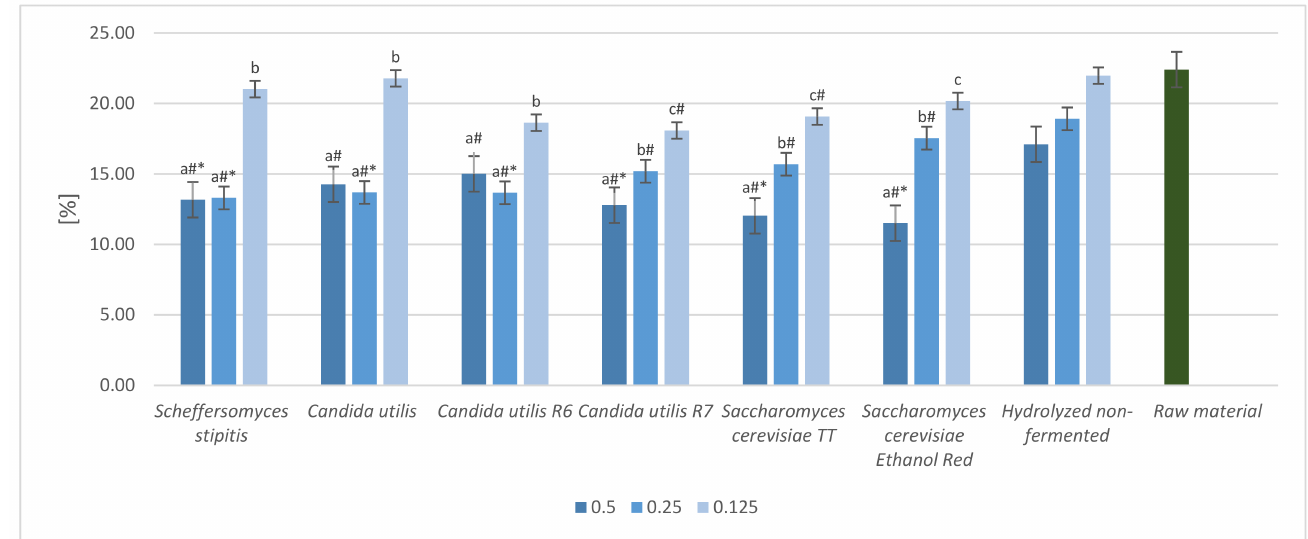
Figure 6. Crude fiber (CF) content after pre-hydrolysis and yeast cultivation on fresh sugar beet pulp hydrolyzed with different enzyme doses (0.5 mL/10 g DM; 0.25 mL/10 g DM; 0.125 mL/10 g DM). a, b, c—indicators of statistically significant difference, mean values for strain with different letters are significantly different ( p < 0.05). *—indicator of significant difference relative to mean value of hydrolyzed non-fermented sample, #—indicator of significant difference relative to the mean value for the raw material ( p < 0.05).